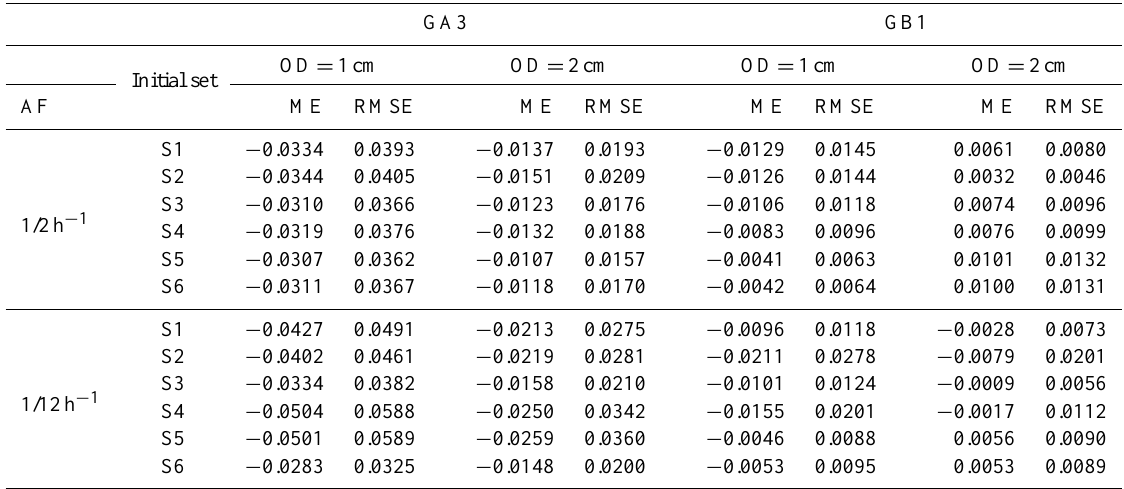
Table 4. Mean error (ME) and root mean square error (RMSE) between predicted and measured soil moisture profiles for GA3 and GB1 data series at the end of the evaporation tests. Values account for the six sets of initial parameters (S1–S6), two observation depths, (OD = 1 and OD = 2cm) and two assimilation frequencies (AF = 1/2h − 1 and AF = 1/12h − 1 )